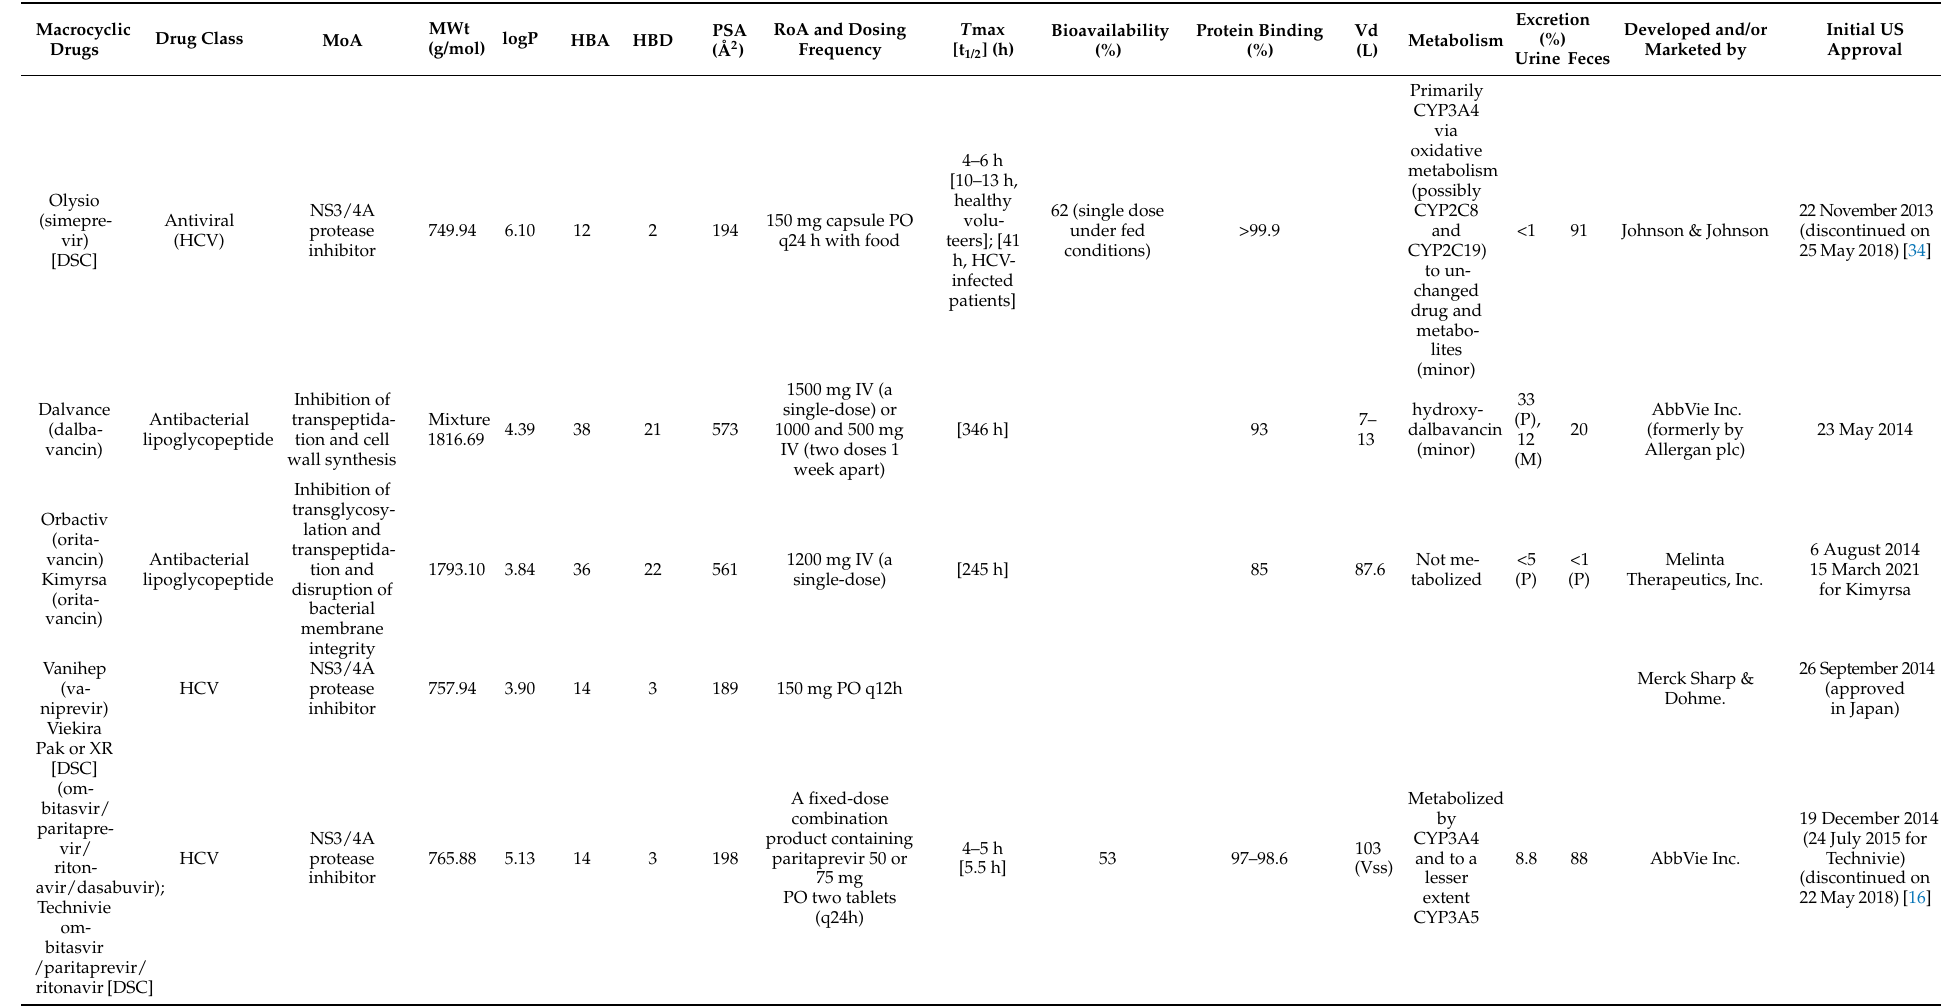
Table 1. Key attributes, physiochemical properties, and PK parameters [32,33] of FDA-approved macrocyclic drugs since